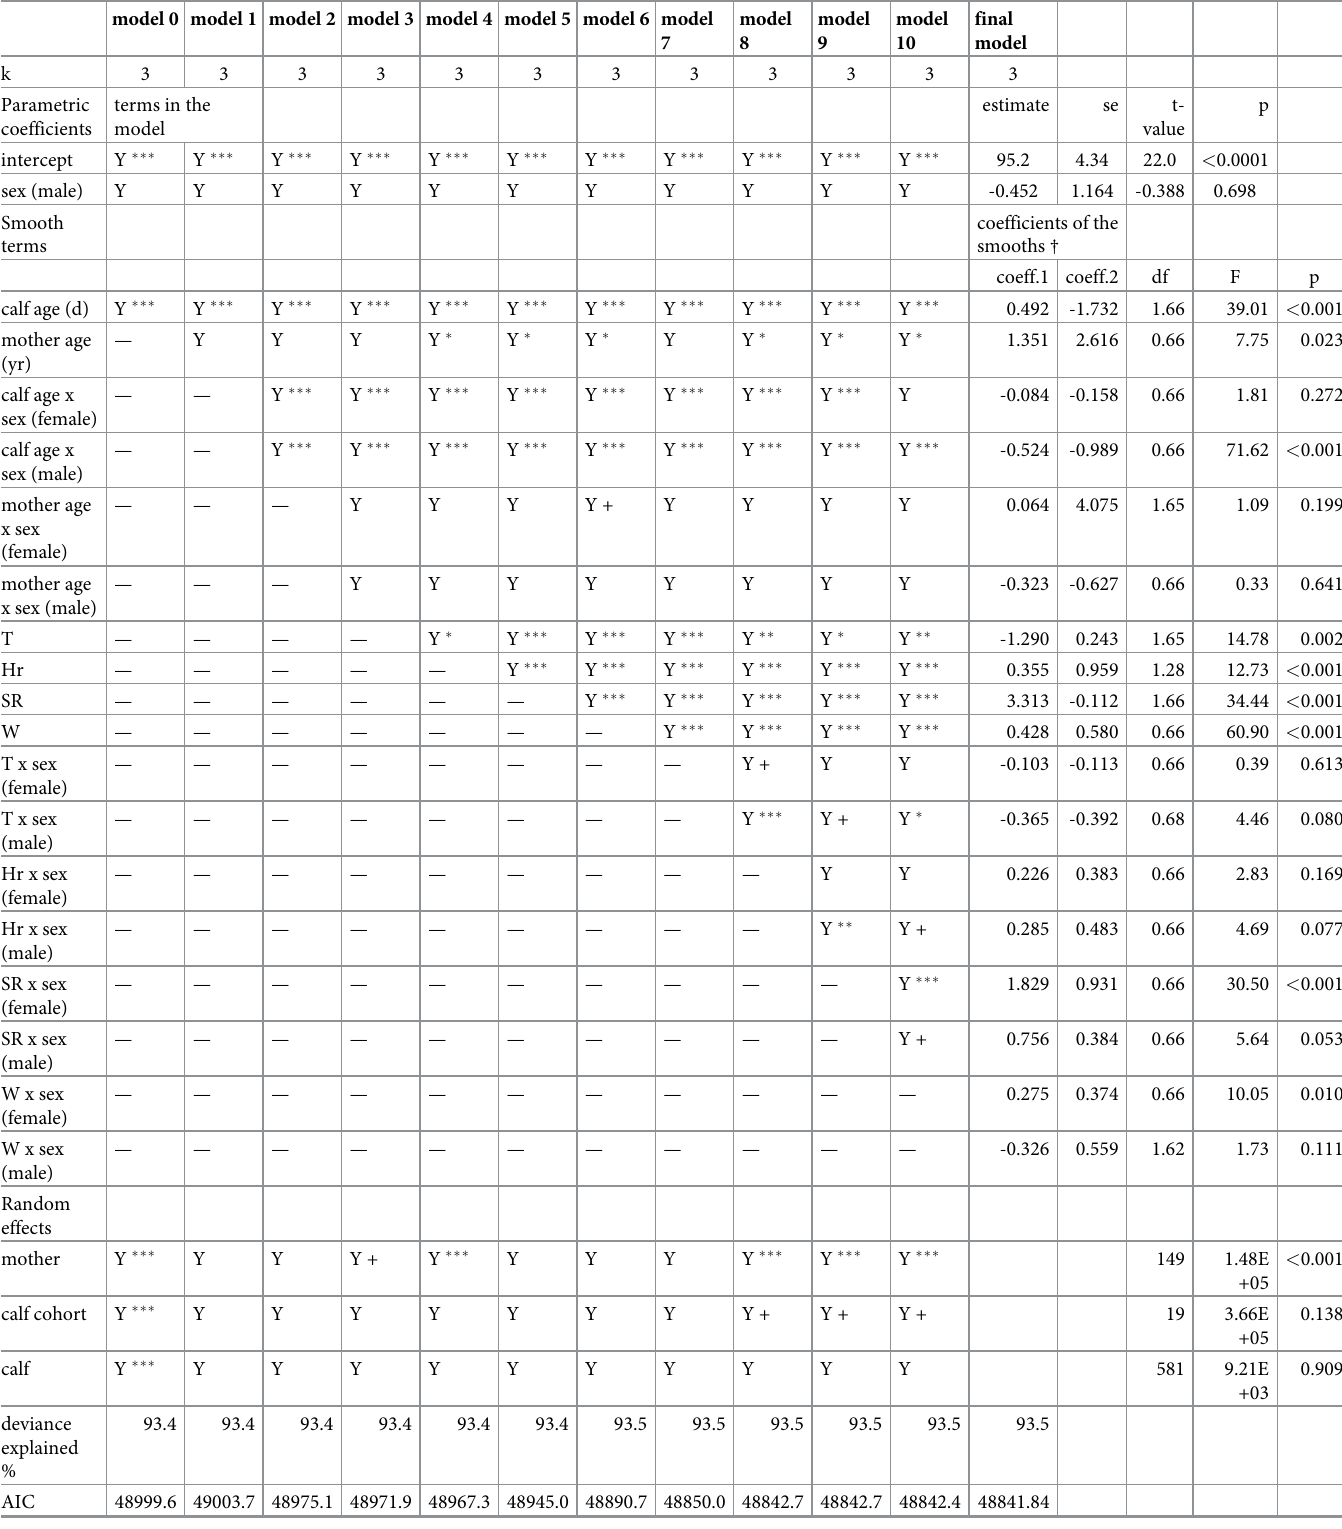
Table 6. Parametric, smooth coefficients and statistics of GAM models on red deer mother weight (kg) together with animal and climatic